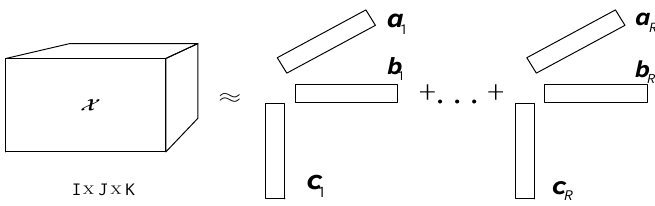
Figure 2. Illustration of an R-component canonical decomposition and parallel factors (CP) model for a 3D tensor.